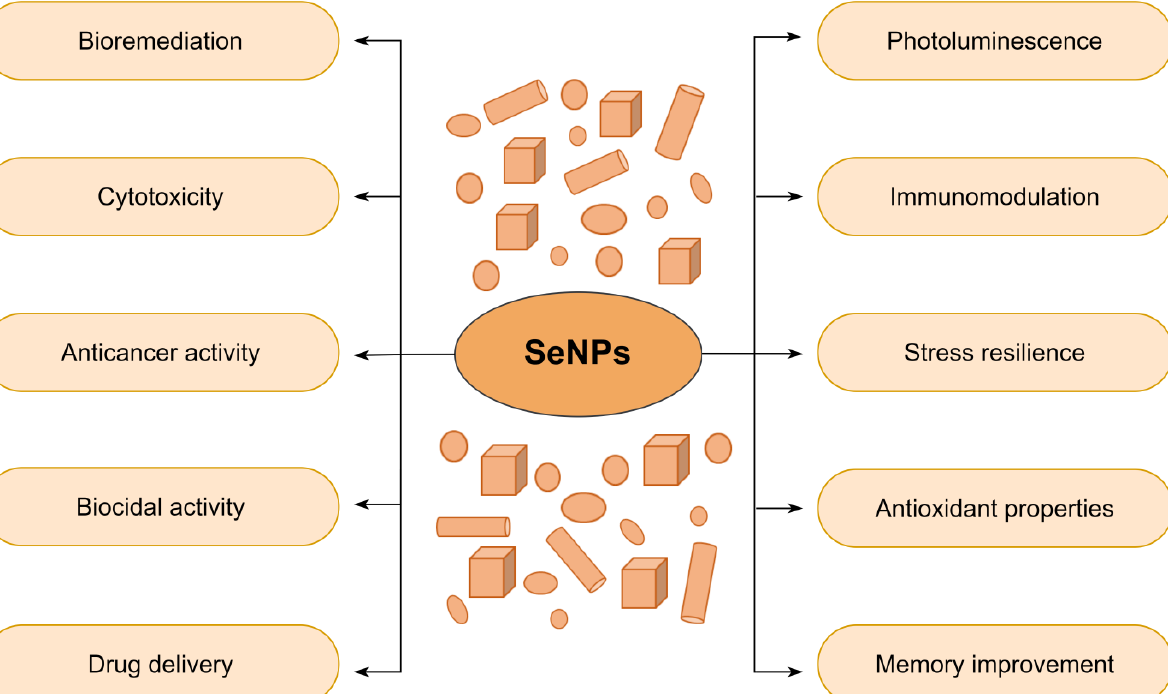
Figure 3. Main biomedical properties and applications of SeNPs.